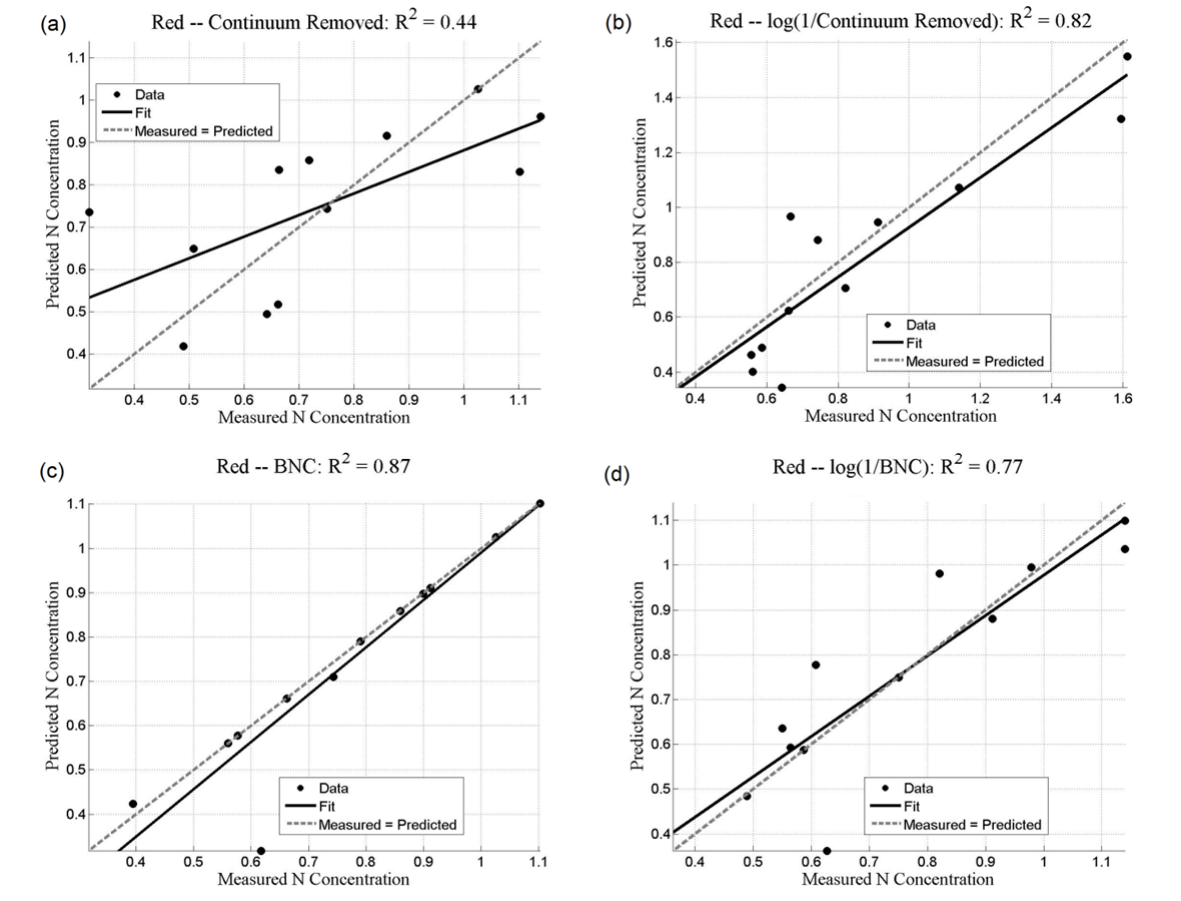
Figure 8. Artificial Neural Network (ANN) testing results for red mangrove reflectance. Dashed line indicates measured concentration = predicted concentration ( i.e. , r 2 = 1)